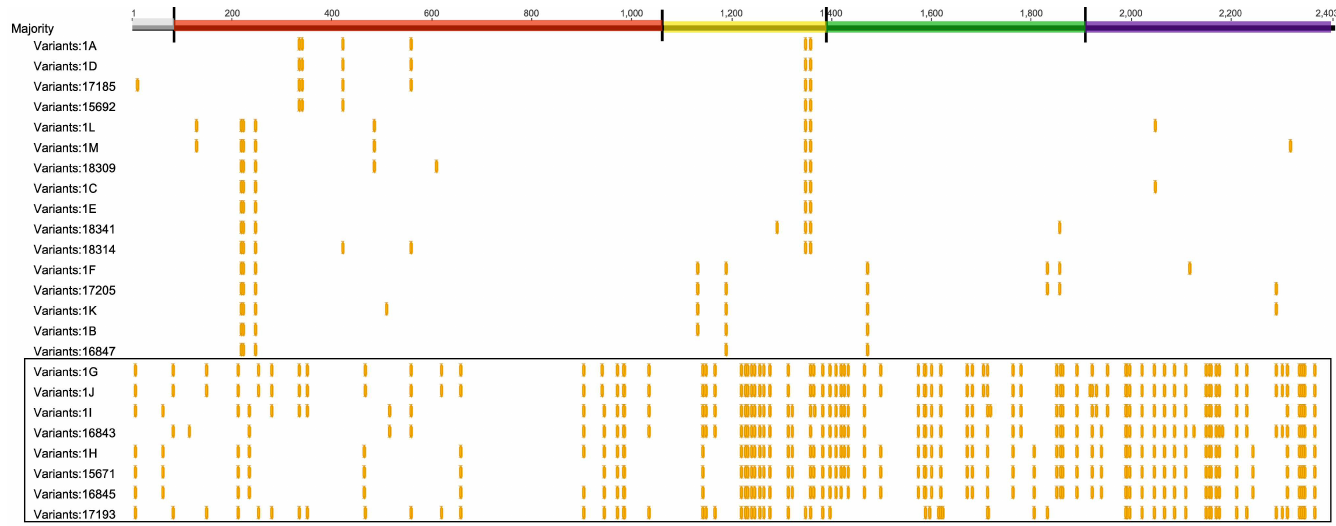
Fig 4. Alignment of Intact Alleles Showing SNP changes. The entire 2403 bp lengthof inlA is shown with the 5 regions as describedin the captionto Fig 2. Bases 1–87 (gray) is the signal sequence,bases 88–1071 (red) is the leucinerich repeat region, bases 1072–1386(yellow)is the intergenicregion, bases 1387–1950(green) is the B repeat region, and bases 1388–2403(purple)is the membraneanchorregion. The boxed alleleswere found only in LineageII strains, while the unboxedalleleswere found only in LineageI